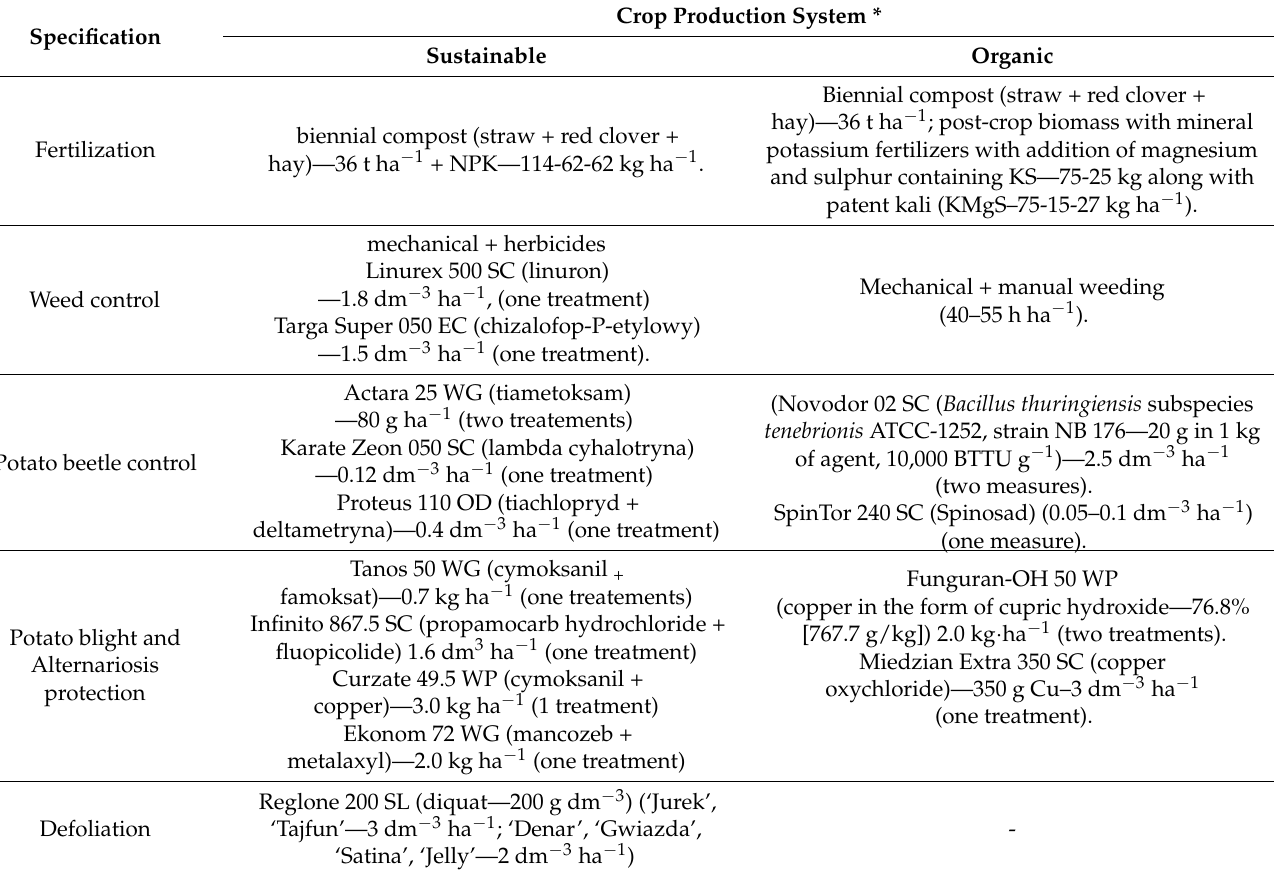
Table 1. Selected elements of potato cultivation in different crop production